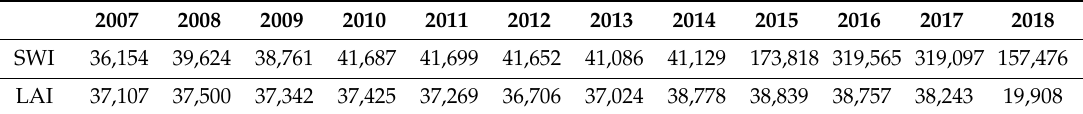
Table 1. Yearly N points of SWI and LAI from 2007 to